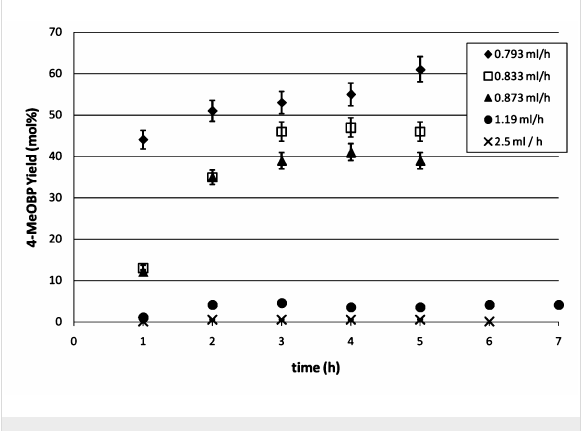
Figure 4: Comparative study of flow rates in a single channel meso flow reactor. The output was sampled hourly and analysed by GC during the period of extended